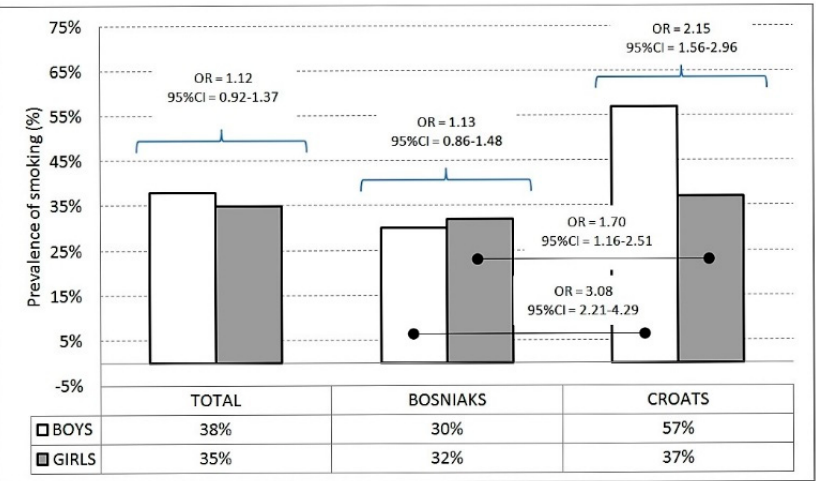
Figure 1. Prevalence of cigarette smoking with odds ratio between and within genders (OR: Odds Ratio; CI: Confidence Interval). Percentage of reported frequency for boys (the 100% being 214 and 485 for Croats and Bosniaks, respectively) and girls (the 100% being 558 and 485 for Croats and Bosniaks, respectively).